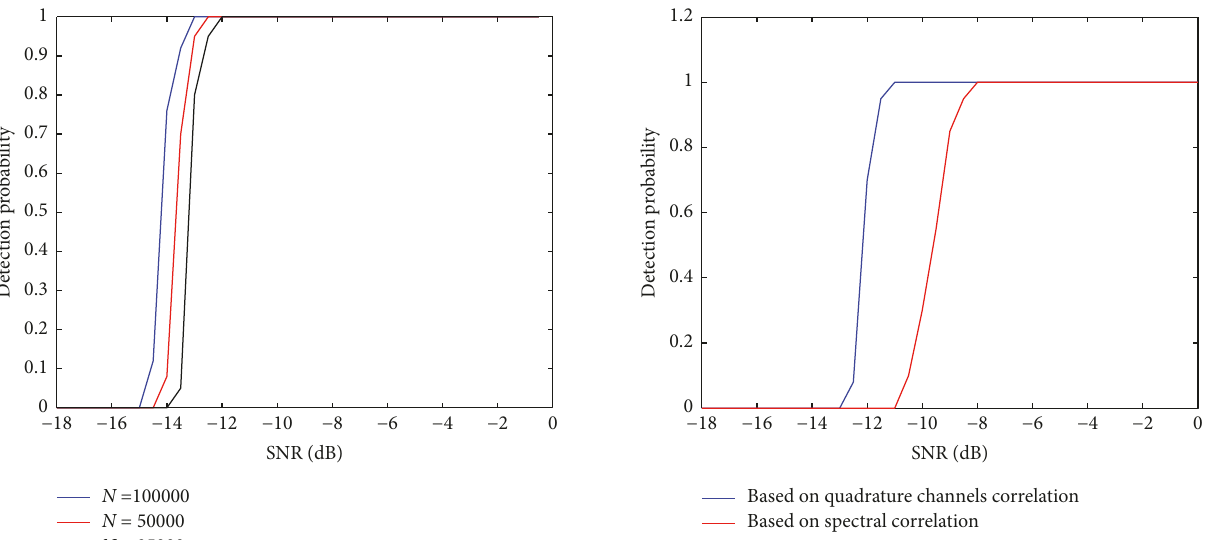
Figure 9: Detection probability with different data lengths.